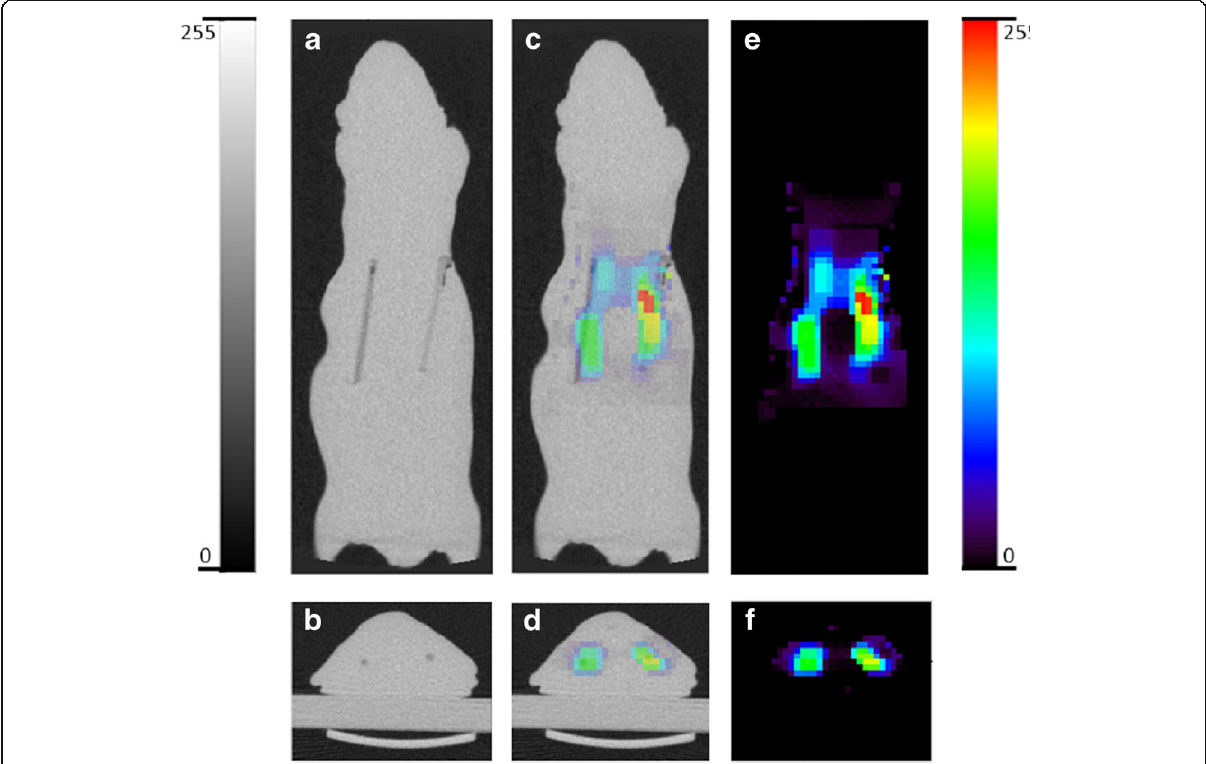
Fig. 3 a Coronal and b transverse sections of the CT image of the mouse-shaped phantom showing the two embedded fluorescent line sources. c Coronal and d transverse overlay of CT and FMT images. e Coronal and f transverse sections of the FMT image showing the two fluorescent line sources reconstructed using both L 1 and TV penalties with regularization parameters of 10 and 1, respectively.